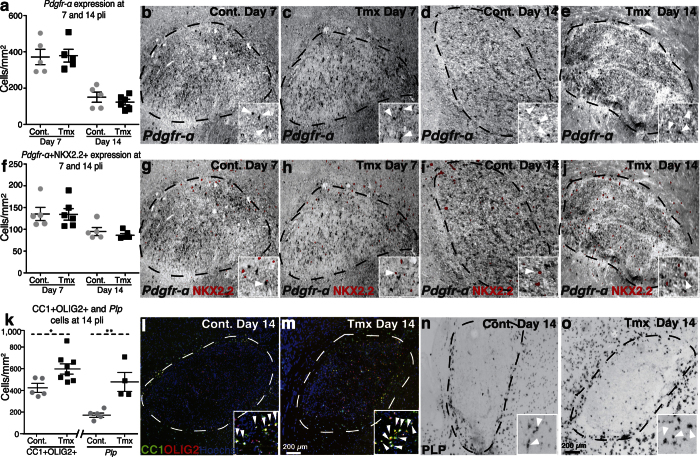
Tamoxifen promotes OPC differentiation after toxin-induced demyelination in white matter.(a) Scatter plot showing comparable numbers of immature OPCs expressing Pdgfr-α in remyelinating lesions at day 7 and 14 (n ≥ 5), Student’s t-test 7 days pli: p = 1.000, 14 days pli: p = 0.2468. (b–e) Representative sections of tamoxifen- (Tmx) and vehicle treated animals labeled by in situ hybridization for Pdgfr-α at 7 pli and 14 pli. (f) Scatter plot demonstrating comparable numbers of Pdgfr-α + /NKX2.2 + activated OPCs in lesions at day 7 and 14 days after demyelination (n ≥ 5), Student’s t-test 7 pli: p = 0.4206, 14 pli: p = 0.9269. (g,j) Representative sections labeled by in situ hybridization for Pdgfr-α and immunohistochemistry for NKX2.2 at 7 pli and 14 pli. (k) Scatter plots demonstrating that tamoxifen treatment significantly promotes OPC differentiation at 14 pli on the basis of increased expression of mature markers (CC1 + /OLIG2 + and Plp + cells) 14 pli (n ≥ 5), Student’s t-test, CC1 + /OLIG2 + : p = 0.0274, Plp + : p = 0.0062. (i–o) Representative sections of lesions labeled by immunohistochemistry for CC1 and OLIG2, or in situ hybridization for Plp at 14 pli. White arrows in the insets point to double positive cells. Error bars: SEM. Scale bar: in b-e, g-j, l-o = 200 μm.